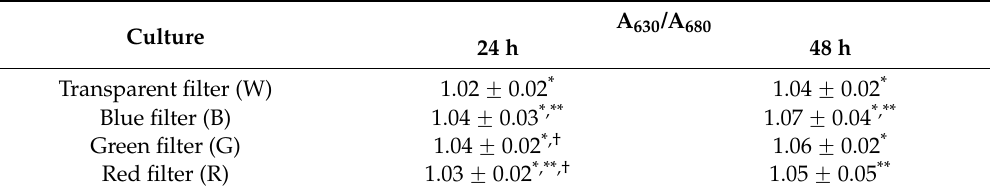
Table 1. The ratio of the in vivo absorbance at 630 nm to the absorbance at 680 nm (A 630 /A 680 ) for the cultures grown under the different filters. White light exposure was ca . 65 µ mol quanta m ´ 2 s ´ 1 . Values significantly differ between the 24 h or 48 h growth period and are indicated by the same superscript (*, **, †). W ‰ B, G or R; **, A ‰ G or R; and †, G ‰ R